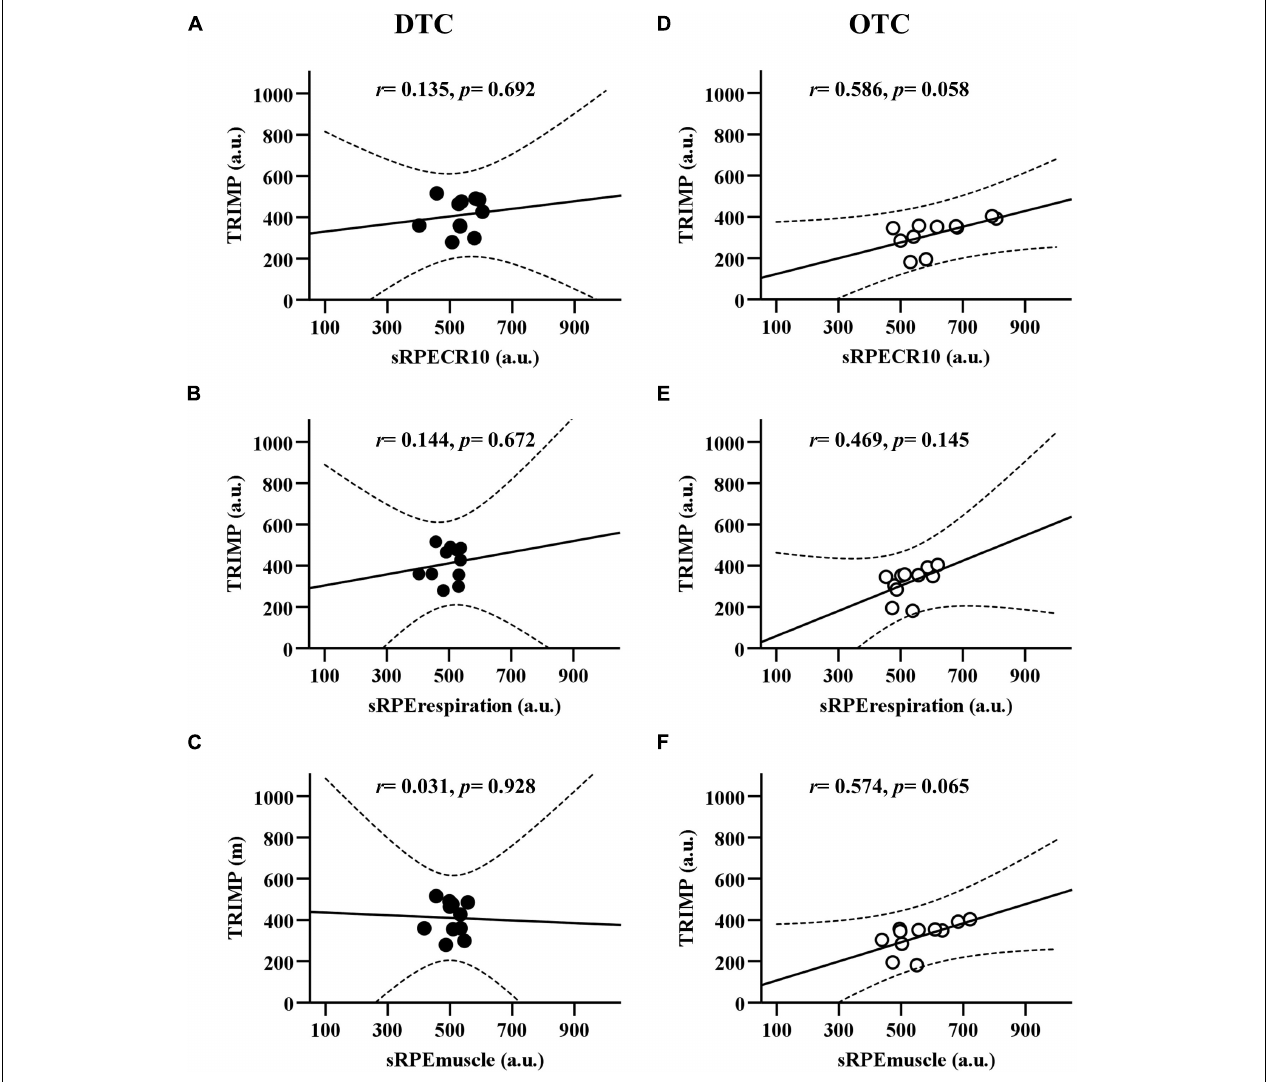
FIGURE 5 | The linear relationship between session RPE (sRPE CR10 , sRPE respiration , and sRPE muscle ) and training impulse during domestic and overseas training camps. (A) Comparison between TRIMP and sRPE CR10 during DTC. (B) Comparison between TRIMP and sRPE respiration during DTC. (C) Comparison between TRIMP and sRPE muscle during DTC. (D) Comparison between TRIMP and RPE CR10 during OTC. (E) Comparison between TRIMP and sRPE respiration during OTC. (F) Comparison between TRIMP and sRPE muscle during OTC. TRIMP, training impulse; sRPE CR10 , session rating of perceived exertion CR10; sRPE respiration , session respiratory perceived exertion; sRPE muscle , session muscular perceived exertion; DTC, domestic training camps; OTC, overseas training